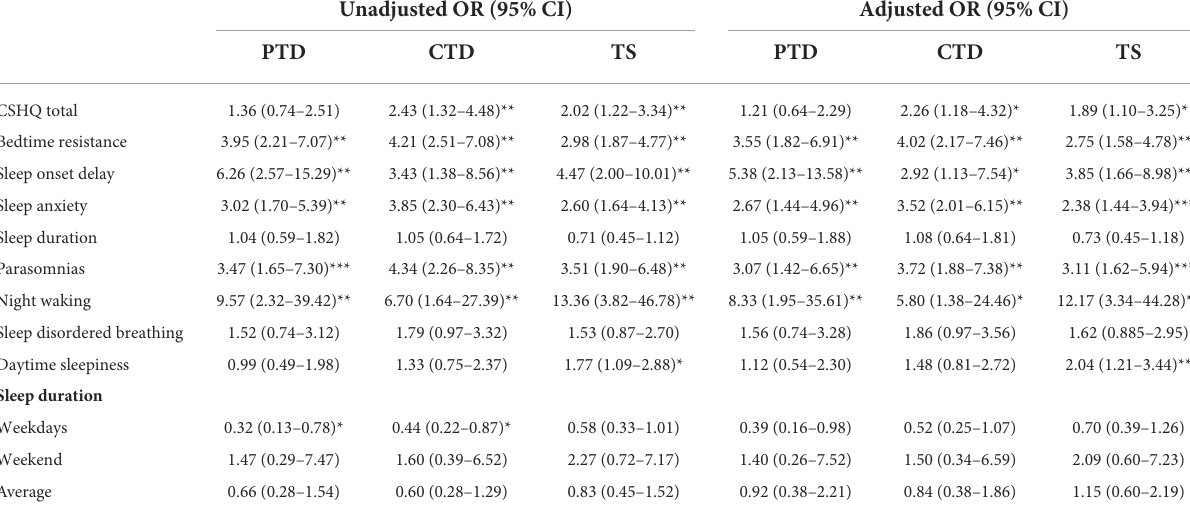
TABLE 6 The association of TD types with sleep disturbances and short sleep duration ( N =